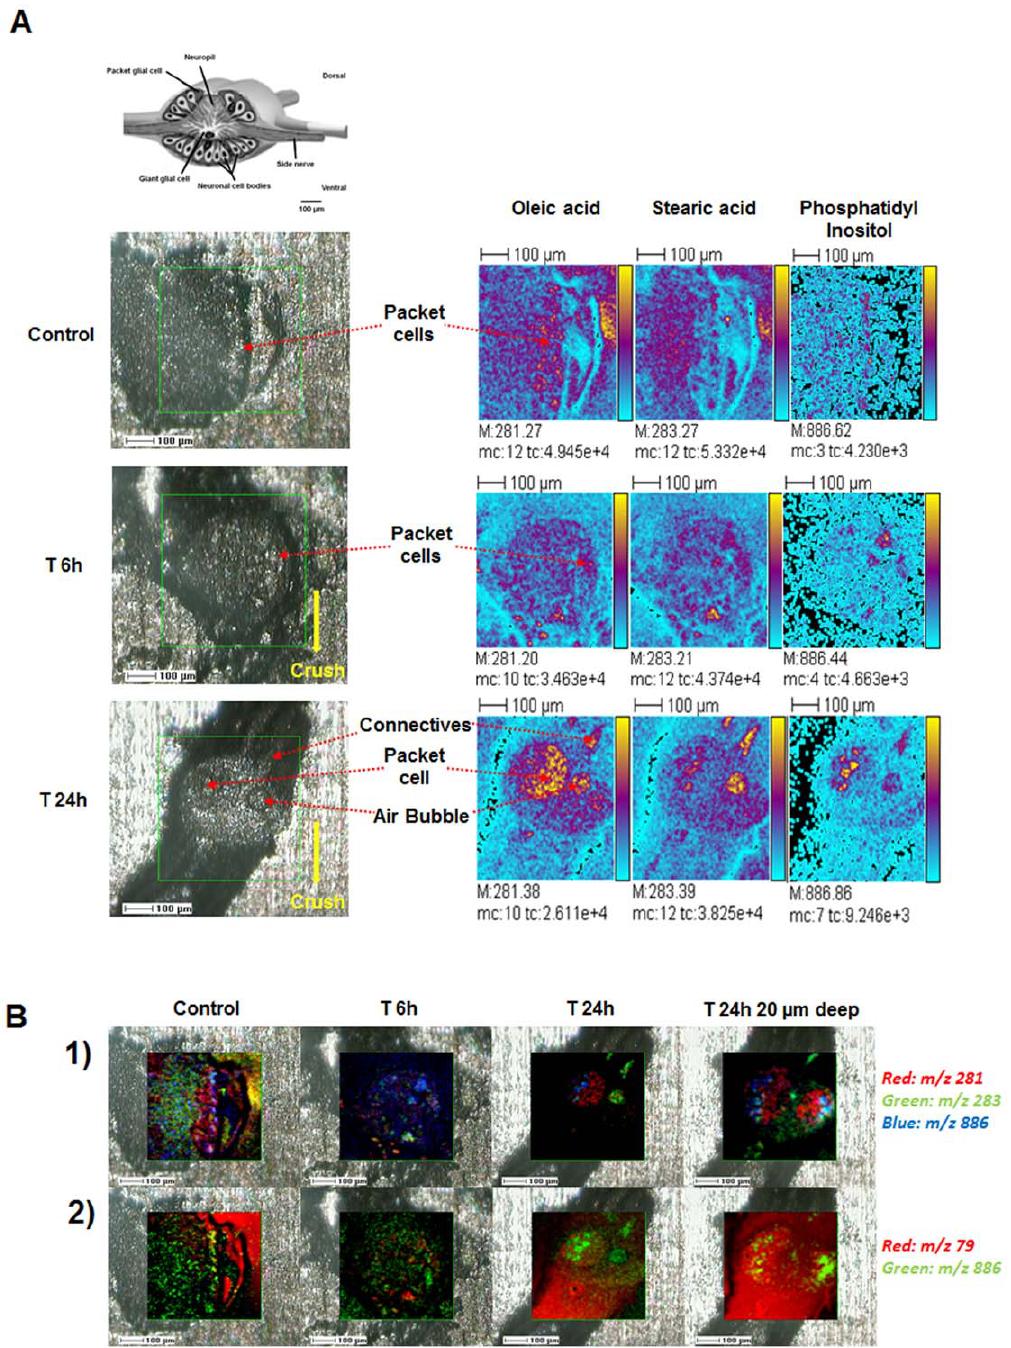
Figure 6. ToF-SIMS lipid ion images of leech ganglia in course of regeneration. A . Drawing of the structure of ganglion (upper left of the panel) [19]. Optical, transmitted light low-resolution images of control, 6 h and 24 h regeneration ganglia included into gelatin 10% before sectioning (lower left of the panel). Highlighting the changing distributions of oleic acid carboxylate ( m/z 281.2), stearic acid carboxylate ( m/z 283.2) and phosphatidylinositol PI34:2 ( m/z 885.5) in these ganglia in course of regeneration by ToF-SIMS imaging (right of the panel). Color scale bars, with amplitude in number of counts, are indicated on the right margin of each ion image. The amplitude of the color scale corresponds to the maximum number of counts mc and could be read as [0, mc ]. tc is the total number of counts recorded for the specified m/z (sum of counts in all the pixels). B . Lipid ion images (color overlays) of leech ganglion in course of regeneration (0:control, 6 h and 24 h regeneration). ( 1 ) Oleic acid carboxylate ( m/z 281.2), stearic acid ( m/z 283.2) and phosphatidylinositol PI34:2 ( m/z 885.5) and ( 2 ) Phosphatidylinositol ( m/z 885.5) and phostate ( m/z 78.9). doi:10.1371/journal.pone.0018359.g006 orthologs, leading us to conclude they are not present in leeches, as noids, the Transient Receptor Potential Vanilloid (TRPV) has been reported in other invertebrates. Mammalian sequences receptors, were then used as query sequences. Tblastn alignments from another group of receptors reported to bind endocannabi- [52] identified two distinct full length putative medicinal leech